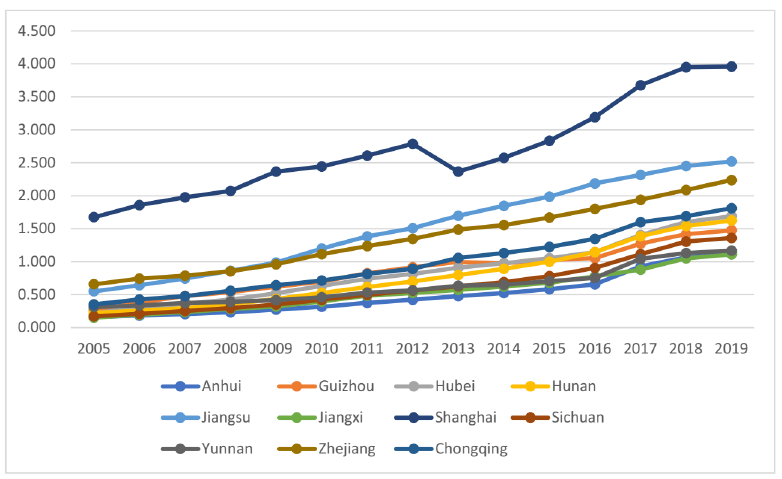
Figure 4. Industrial structure upgrading